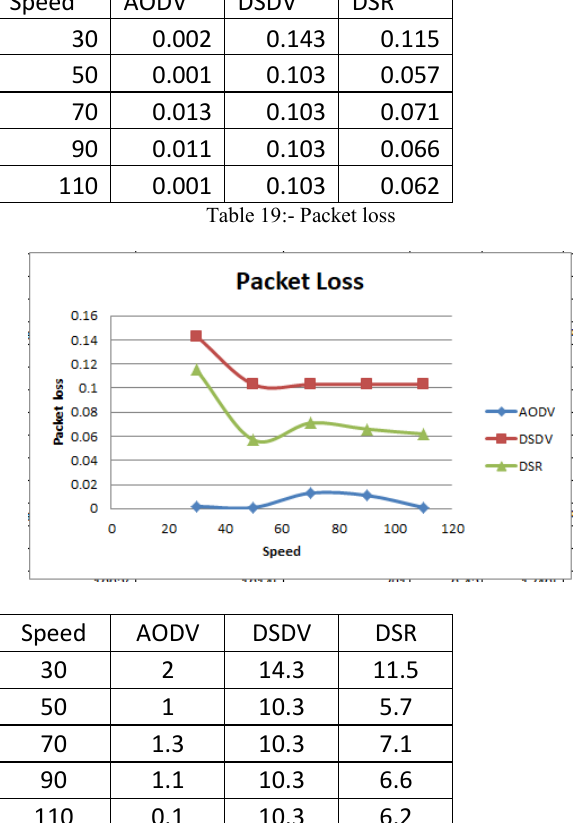
Table 20:- Average End to End Delay